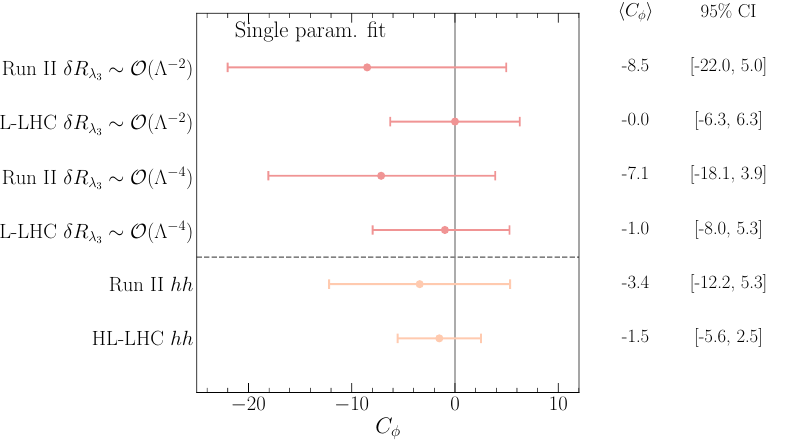
Figure 9 . A forest plot illustrating the means and 95% CIs of the posterior for C φ from a single- parameter fit, showing also the differences in including terms of O (1 / Λ 2 ) or up to O (1 / Λ 4 ) in the definition of δR λ . For comparison, also the limits and projections from searches for Higgs pair 3 production are